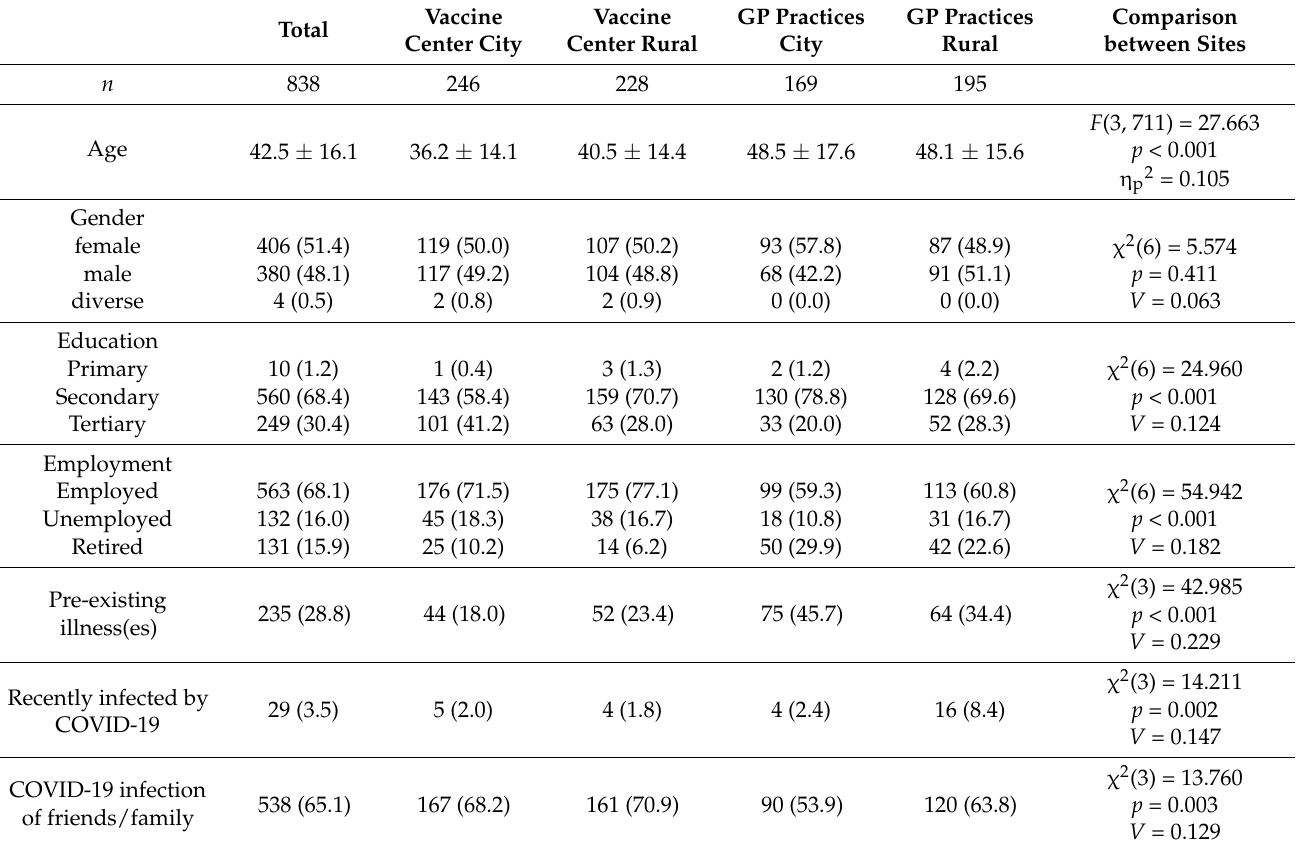
Table 1. Sociodemographic sample characteristics and comparison between vaccine sites. Vaccine Vaccine GP Practices GP Practices Comparison Center City Center Rural City Rural between